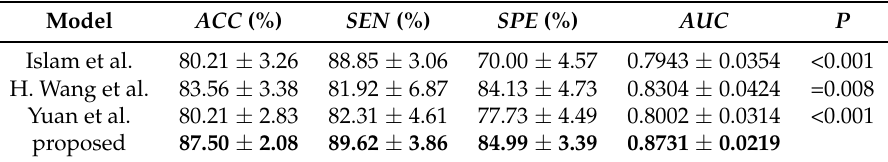
Table 15. Classification performance of different methods for T1 task.